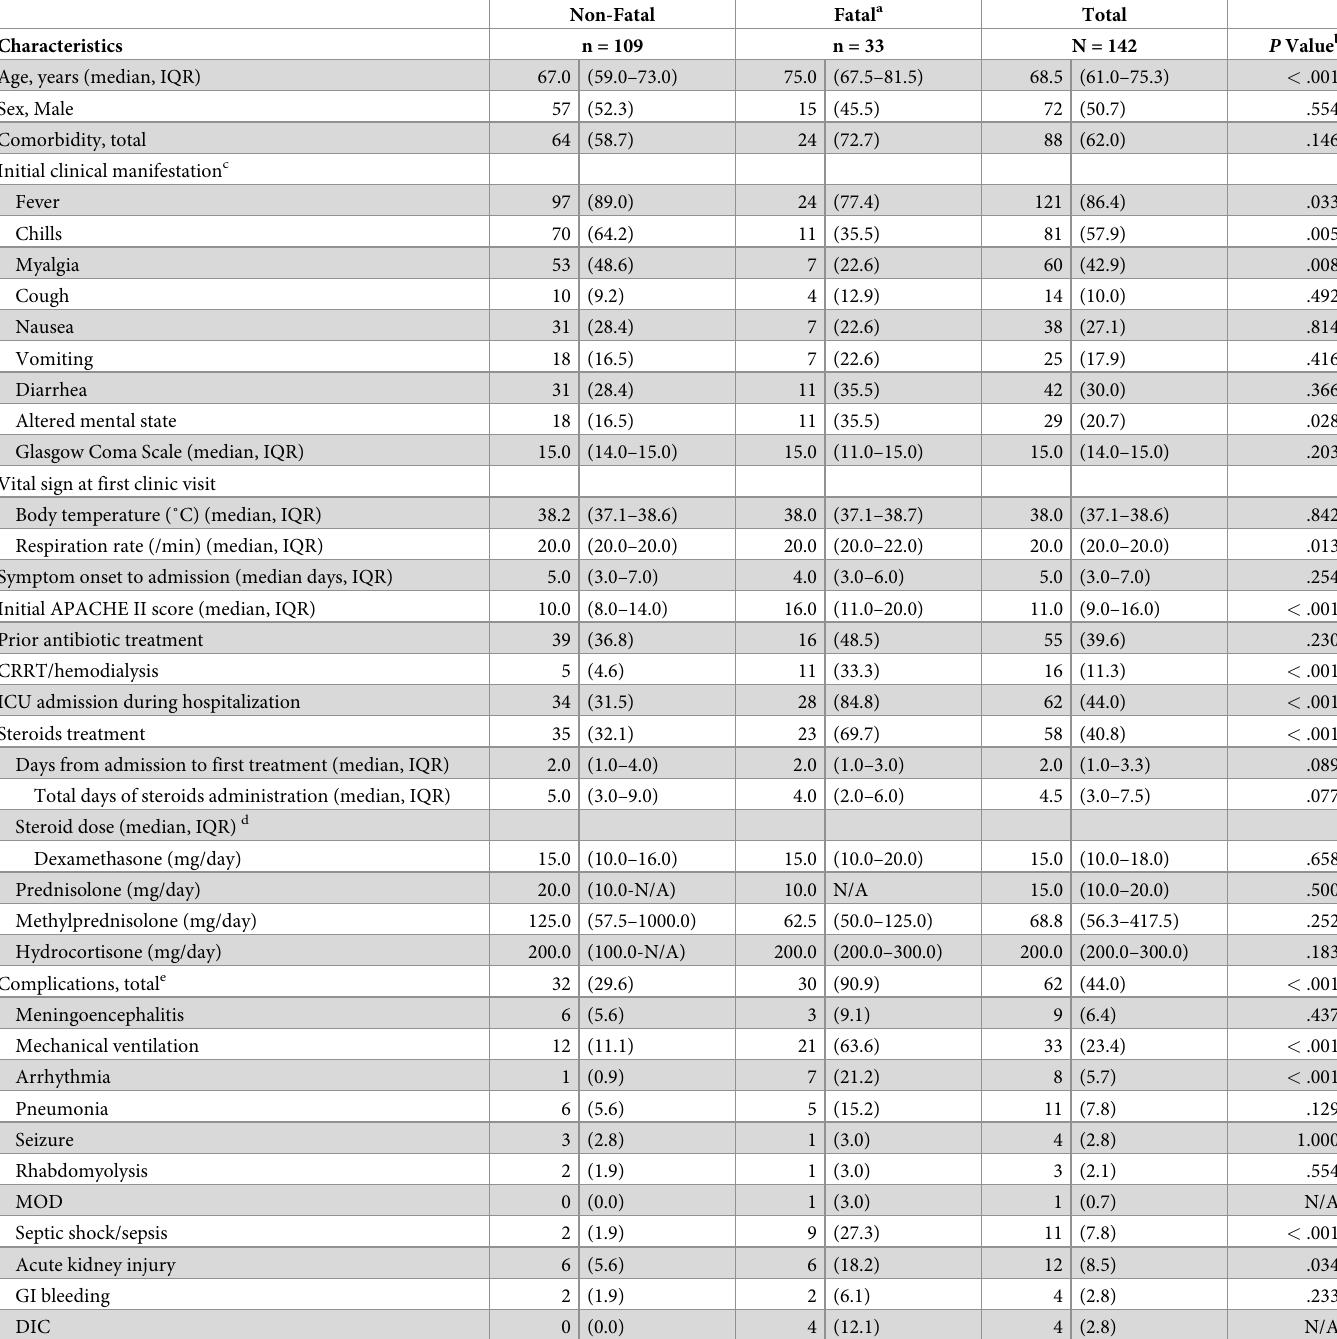
Table 1. General and Clinical Characteristics of Patients with SFTS in the Non-Fatal and Fatal Groups